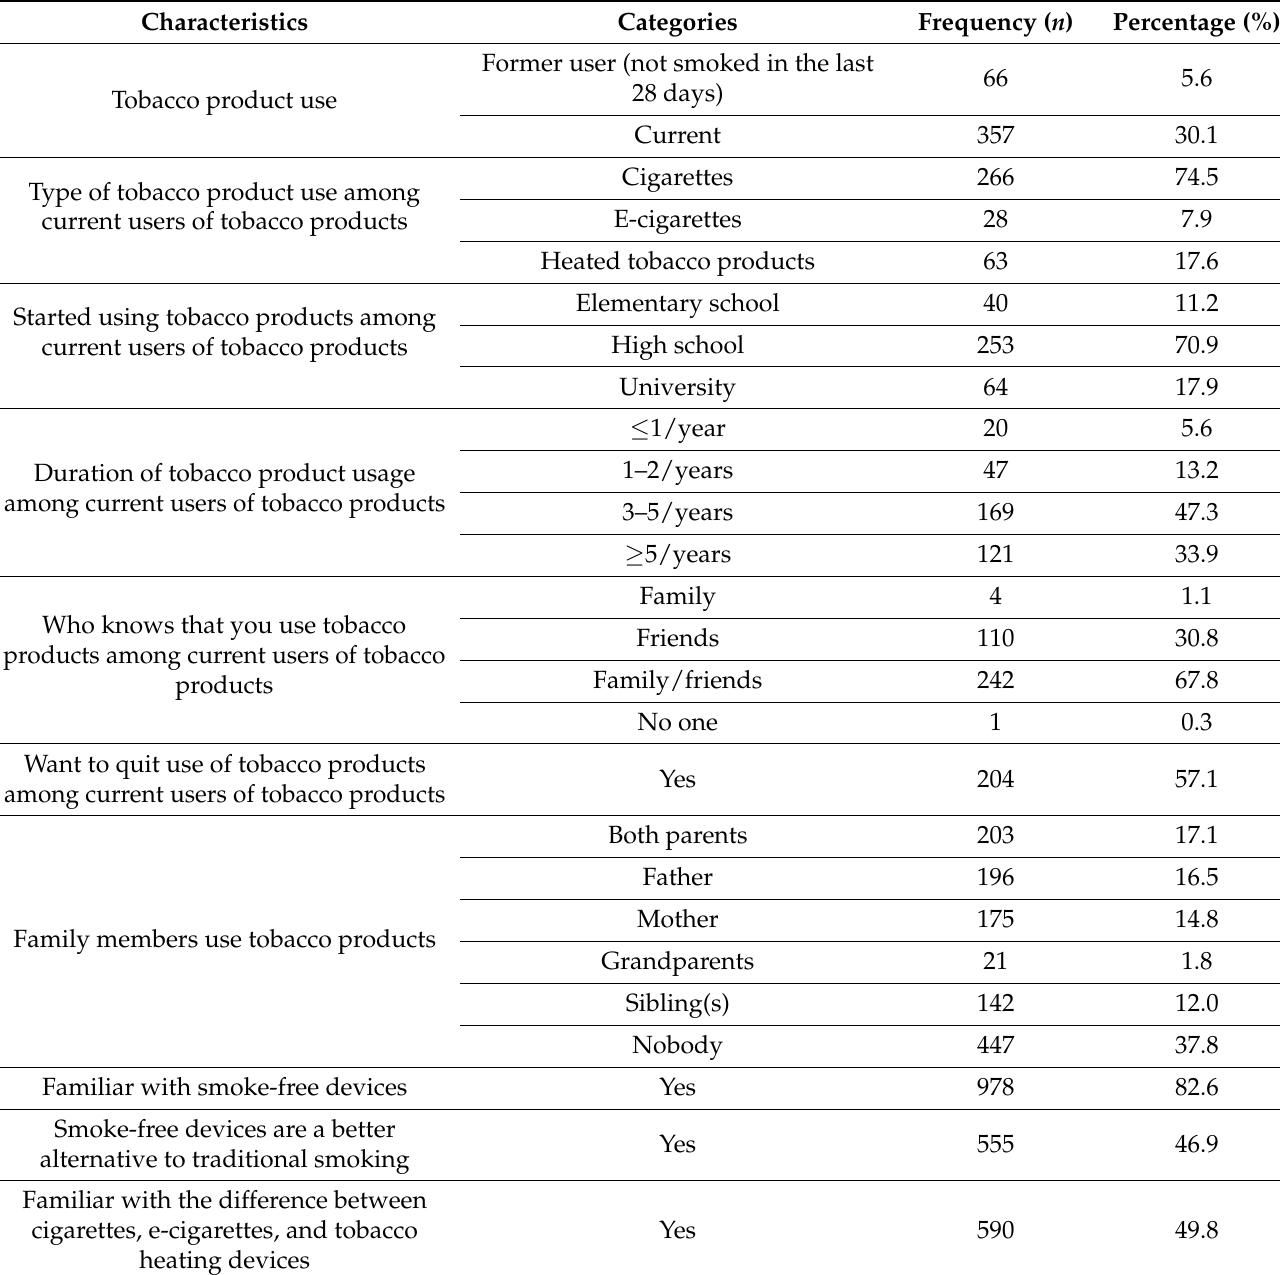
Table 2. Characteristics of respondents related to tobacco use behavior based on mean score for knowledge of tobacco products and their harmful effects ( n =